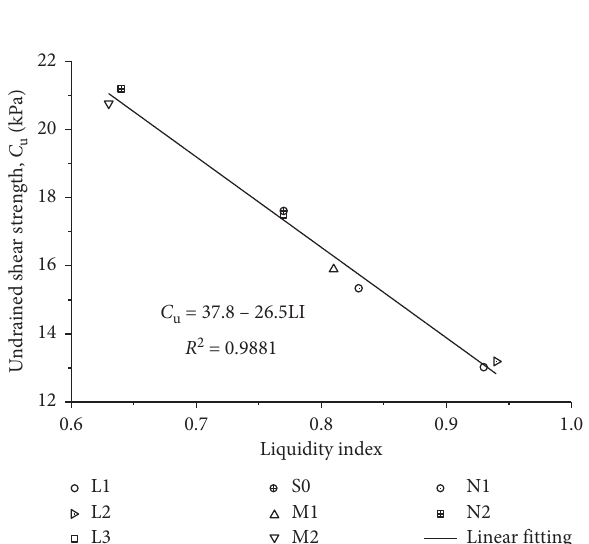
Figure 12: Relationship of undrained shear strength versus li- quidity index of the consolidated soft